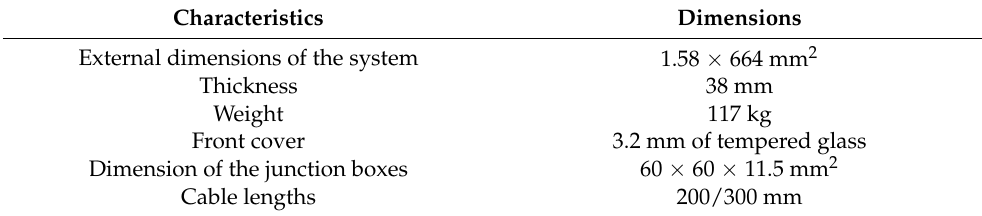
Table 2. Technical characteristics of PVs.